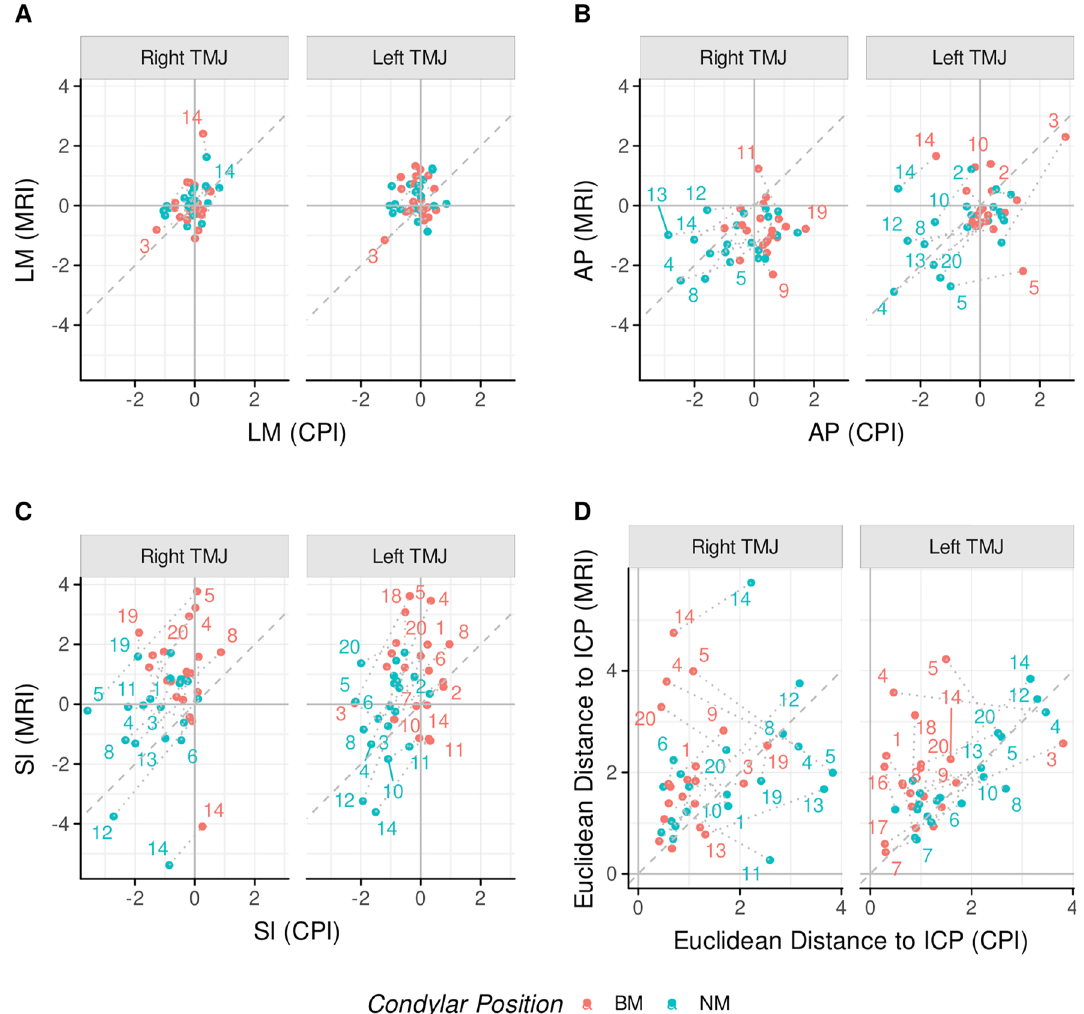
Figure 5. Plot of concordance between CPI and MRI. CPI condylar positions (x-axis) and MRI condyle positions (y-axis), separately for BM (red) and NM (blue) in lateral–medial direction ( A ), anterior–posterior direction ( B ), and superior–inferior direction plane ( C ). ( D ) Illustrates 3D Euclidean distances from intercuspal position (ICP) to BM or NM. Full agreement between CPI and MRI is represented by the line of identity (grey dashed line).